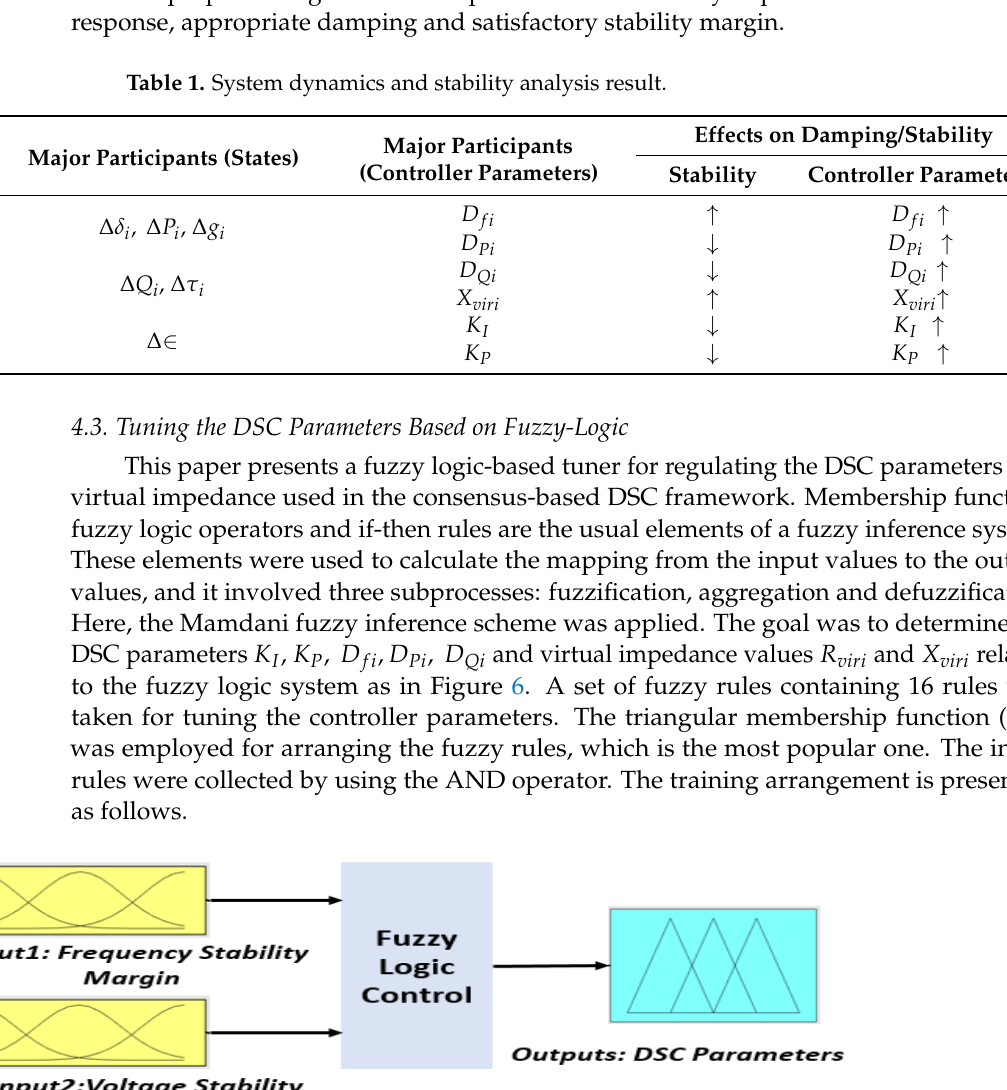
( d ) Figure 7. Membership functions for ( a ) input1, frequency stability region; ( b ) input2, voltage stability region; ( c ) output1, active power gain, 𝐷 𝑃𝑖 and ( d ) output2, reactive power gain, 𝐷 𝑄𝑖 .